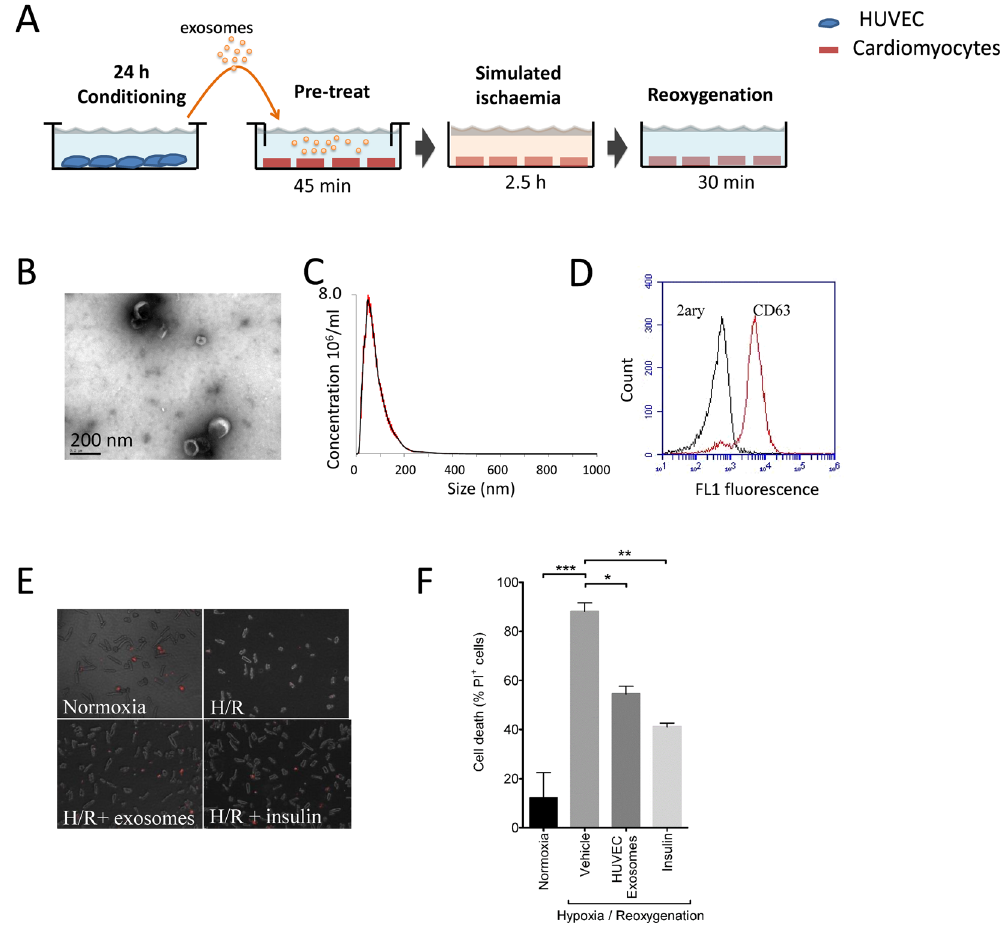
Figure 2. HUVEC release cardioprotective exosomes. ( A ) Experimental protocol in which cardiomyocytes were pre-treated with HUVEC exosomes before H/R. Separate wells of cardiomyocytes were maintained in normoxic medium. Insulin pre-treatment was used as a positive control for cardioprotection. ( B ) Electron micrograph of purified exosomes from HUVEC cells. ( C ) Representative size and concentration distribution of HUVEC exosomes purified from HUVEC cells after 24 h culture, determined by nanoparticle tracking analysis. ( D ) Flow cytometric analysis exosome-coated microspheres confirmed the presence of exosomal marker CD63. ( E , F ) Percentage of dead cells after normoxic culture, after H/R, after exposure to HUVEC exosomes, or insulin (N = 3). * P < 0.05, ** P < 0.01, *** P <